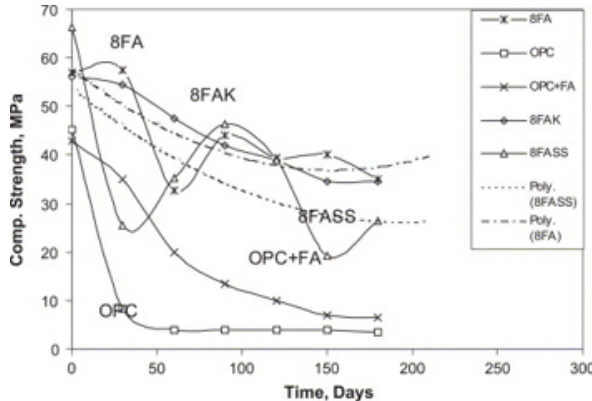
Figure 9: Compressive strength evolution of the geopolymer and Portland cement specimens exposed to 5% acetic acid solution [13]